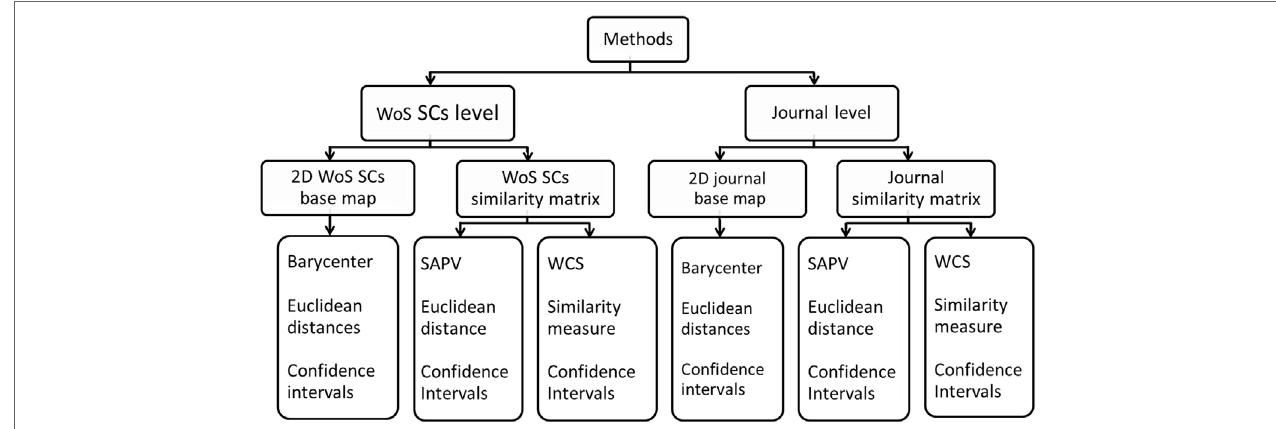
FigUre 1 | Main components of the six approaches at a